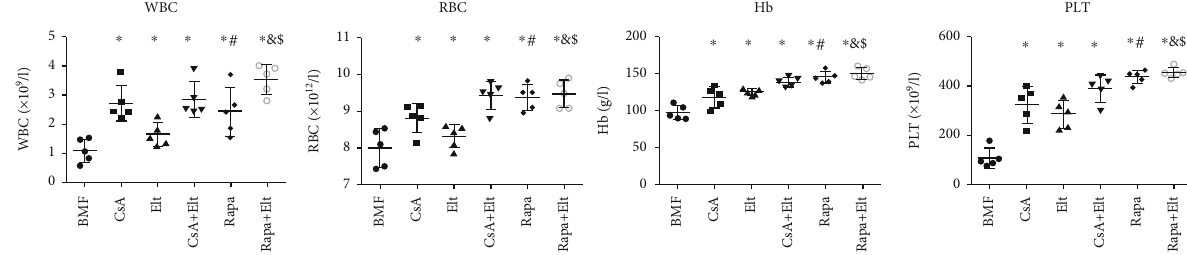
Figure 2: Improve the complete blood counts of the AA mice after rapamycin and eltrombopag treatment. ∗ Compared with the AA group ( P < 0 : 05 ). # Compared with the CsA group ( P > 0 : 05 ). & Compared with the Rapa group ( P < 0 : 05 ). $ Compared with the Rapa group ( P < 0 : 05 ).